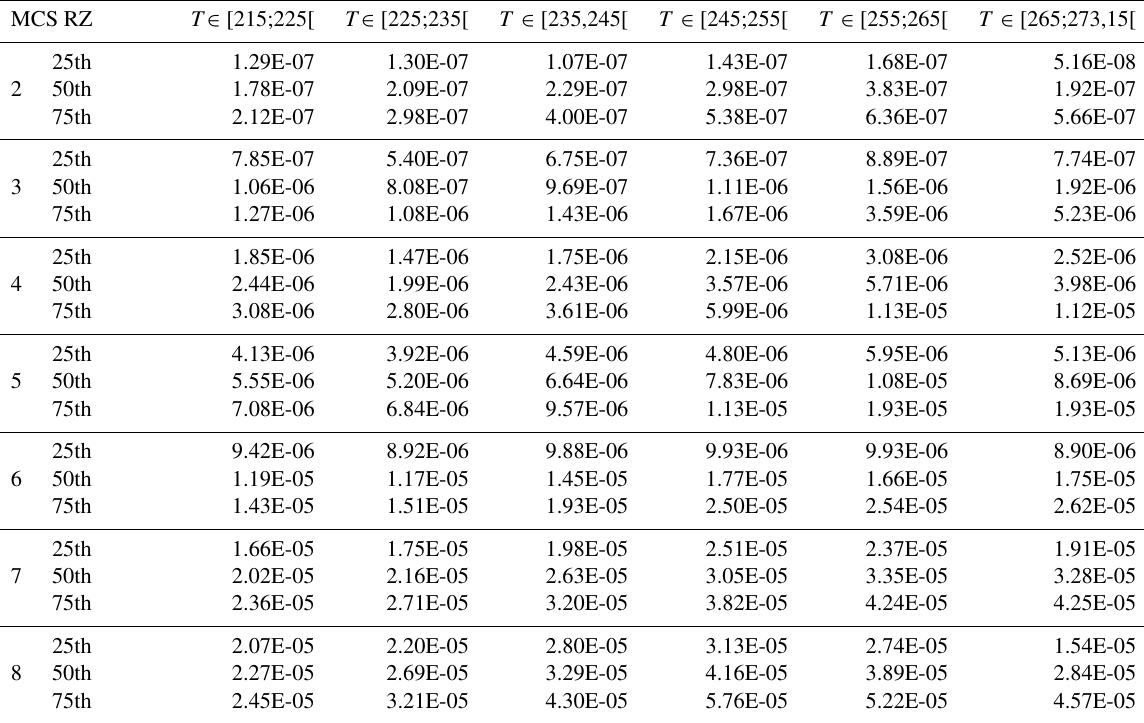
Table C11. The third moment of PSD ( M 3 ; no dimension)(Fig.